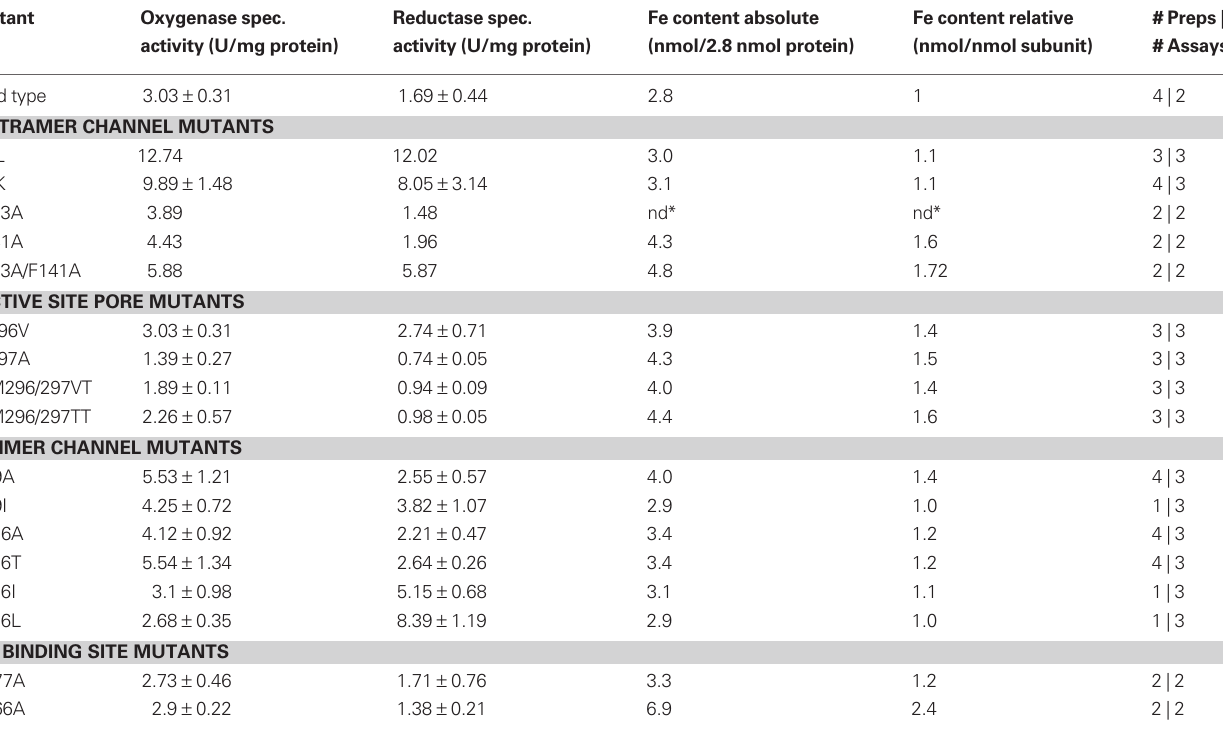
Table 2 | Specific activities of wild type and mutant SOR, iron content, numbers (#) of preparations and assays per preparation. Mutant Oxygenase spec. Reductase